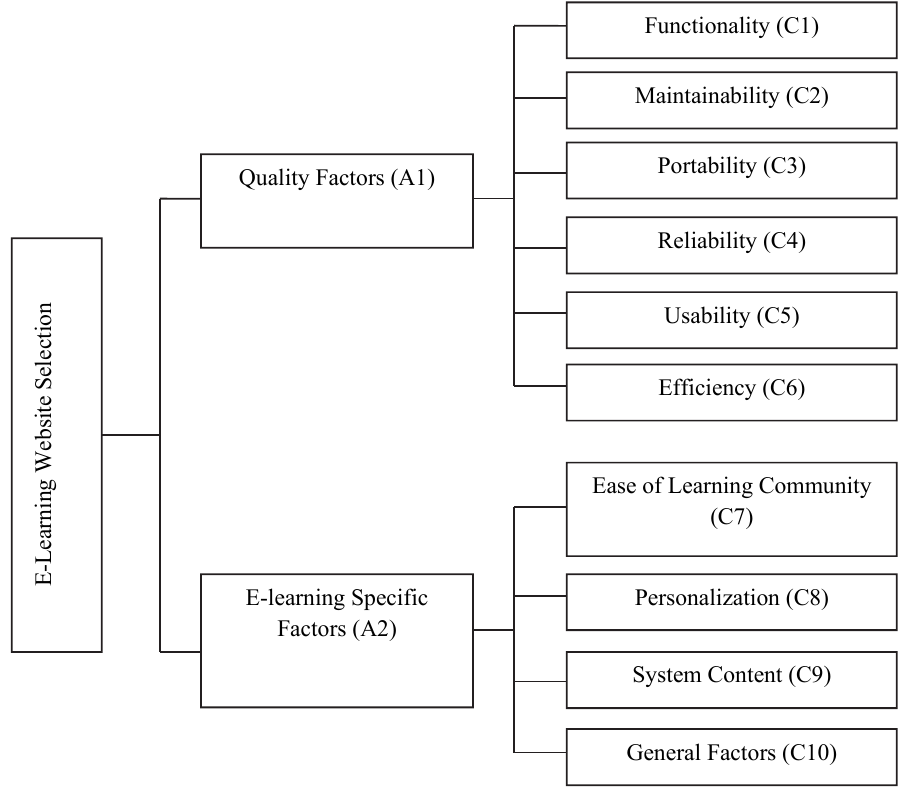
Fig. 3. Hierarchical structure of the selection